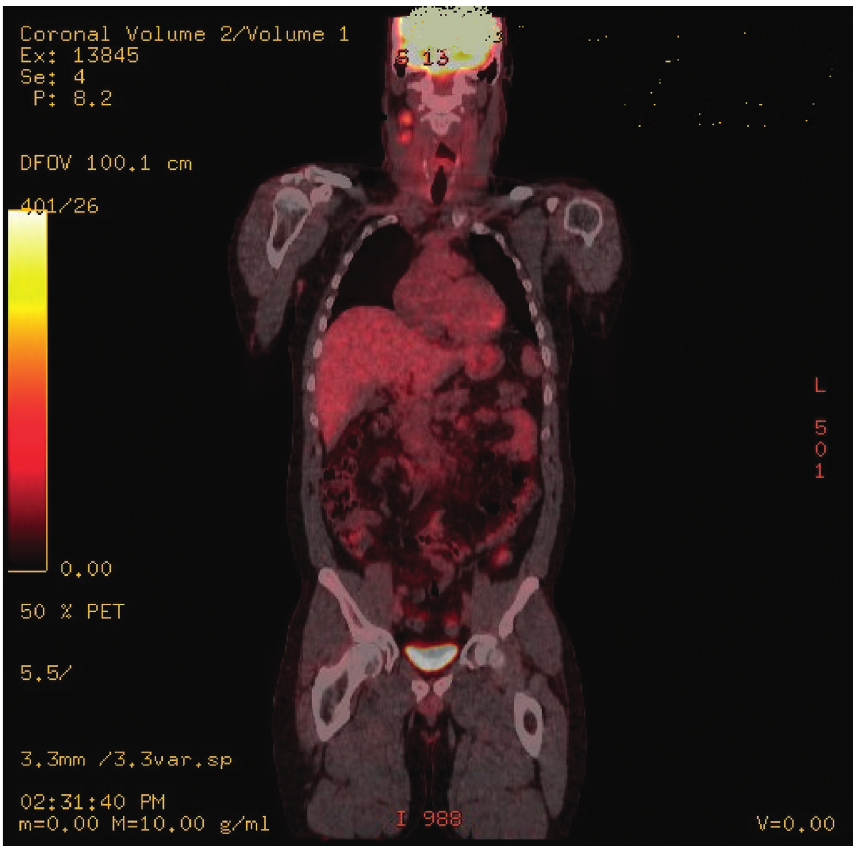
Figure 5: FDG-PET scan showing increase in uptake in two upper cervical lymph